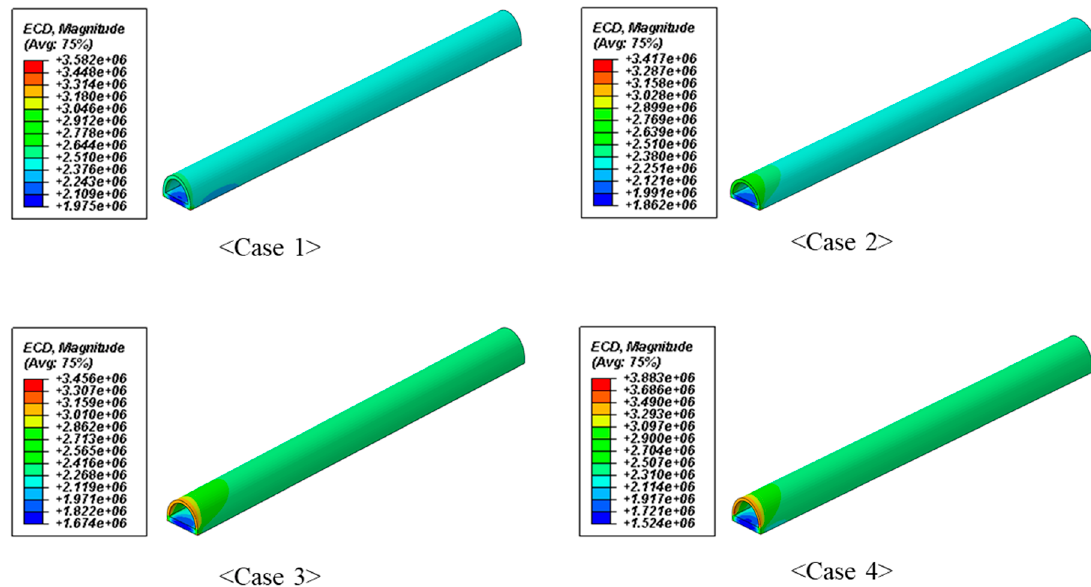
Figure 4. Results of the current density distribution analysis as a function of the thickness of tunnel-type bus-bar.